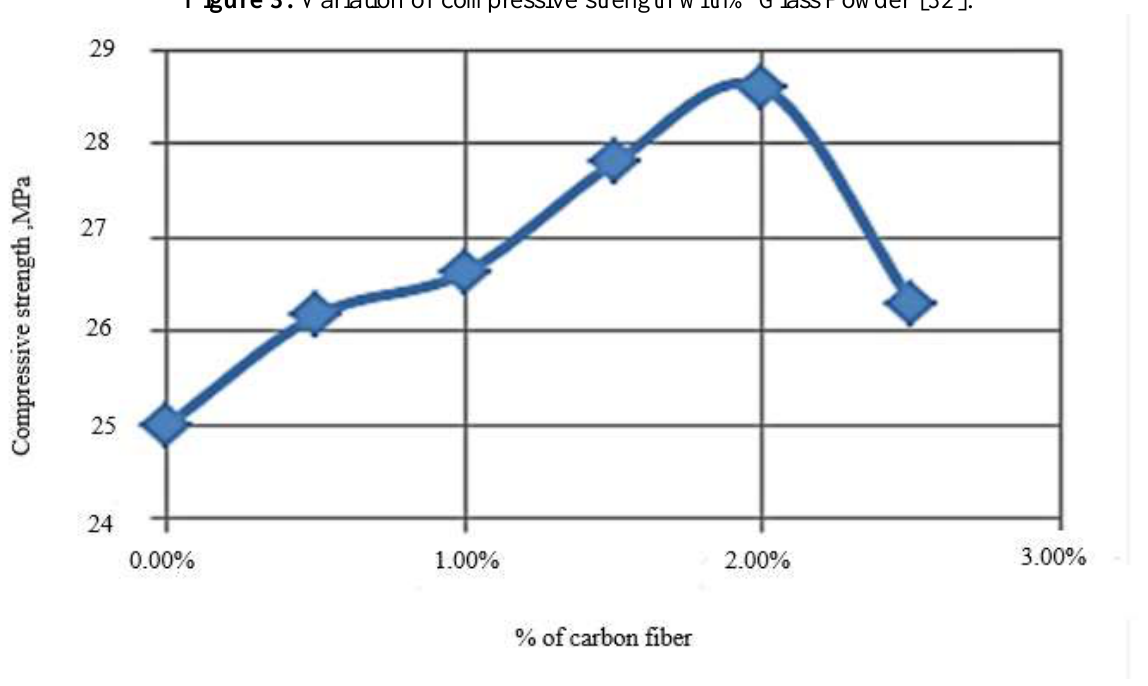
Figure 3: Variation of compressive strength with% Glass Powder [32].